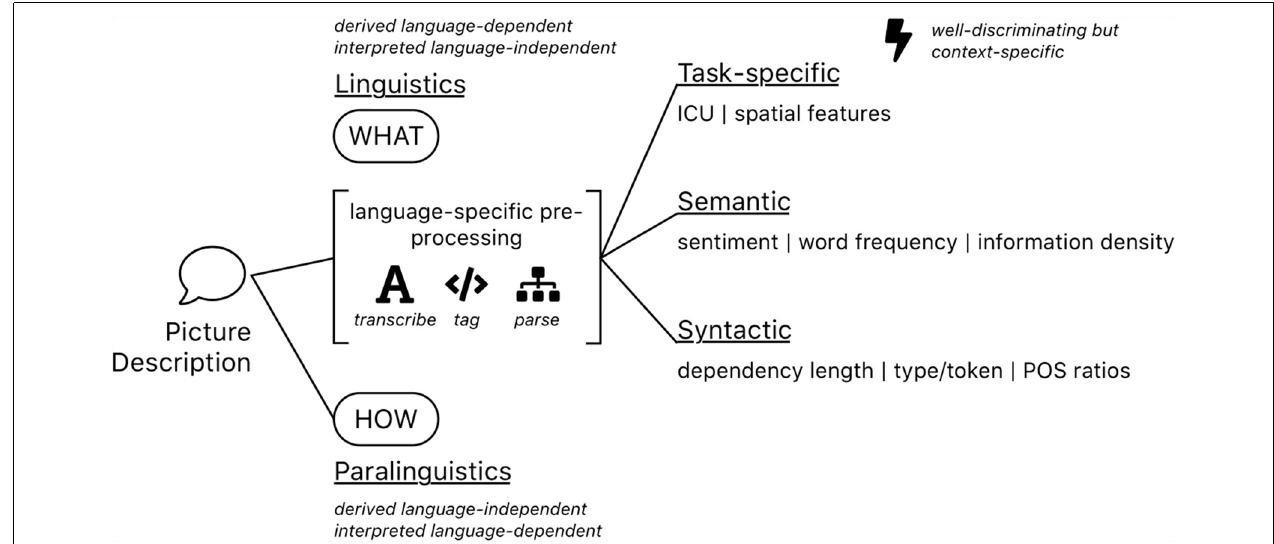
FIGURE 1 | A schematic overview of feature kinds that are typically extracted from spontaneous speech picture descriptions. Some of them involve extensive pre-processing steps such as automatic speech recognition (ASR), part of speech tagging or sentence parsing and additional linguistic resources for calibration, others